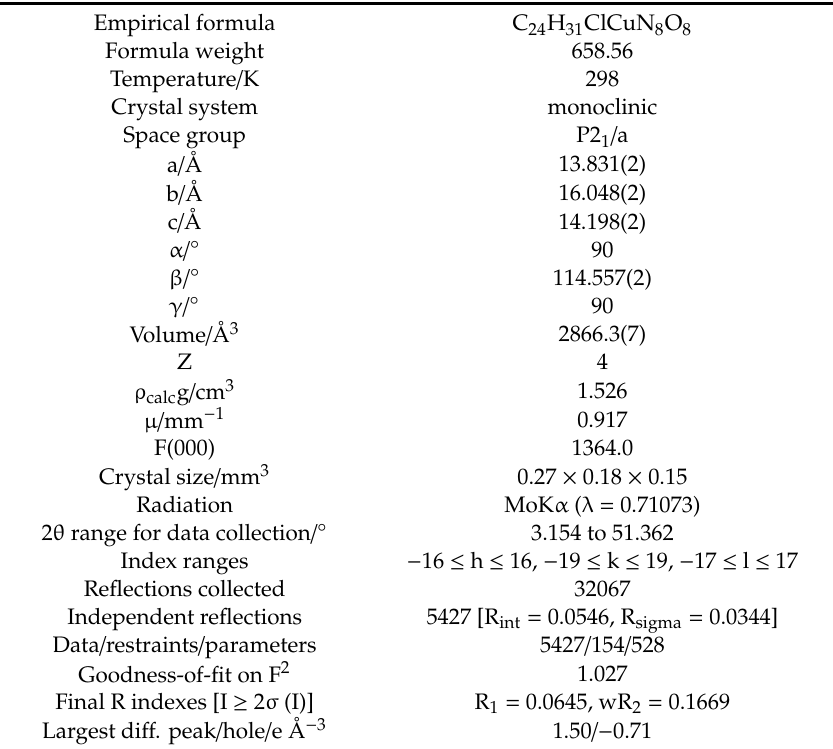
Table 1. Summary of X-ray crystallographic data for ( 1